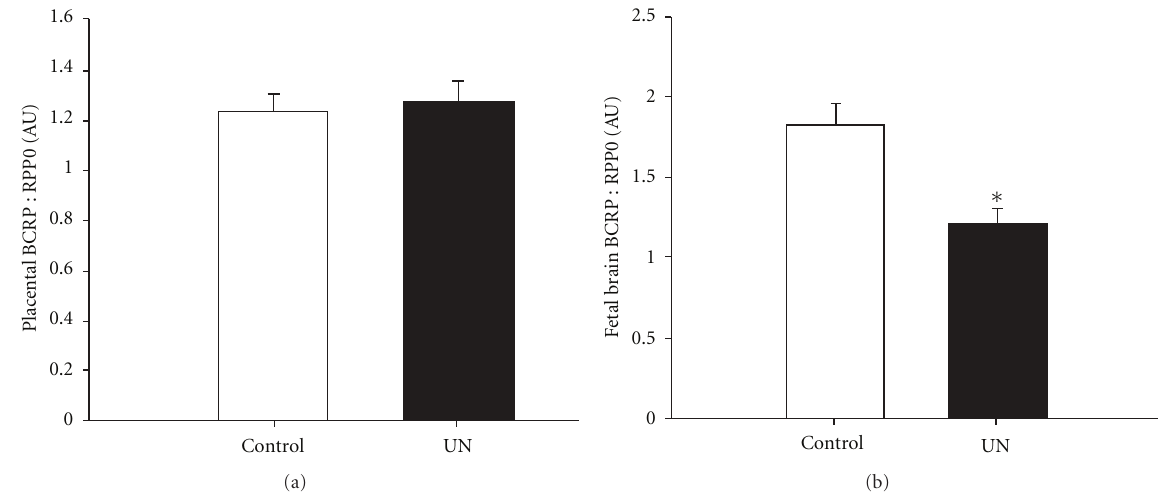
Figure 2: Placental (a) and fetal brains (b) BCRP gene expression in control (open bar, n = 6) and maternal undernutrition (UN; filled bar, n = 7) at 60–62 days of gestation (term, 69 days) in the guinea pig. BCRP gene expression (mean ± SEM) was quantified by real-time PCR. There was a decrease in BCRP gene expression in the UN fetal brain but not the placenta compared with controls. P < 0 .